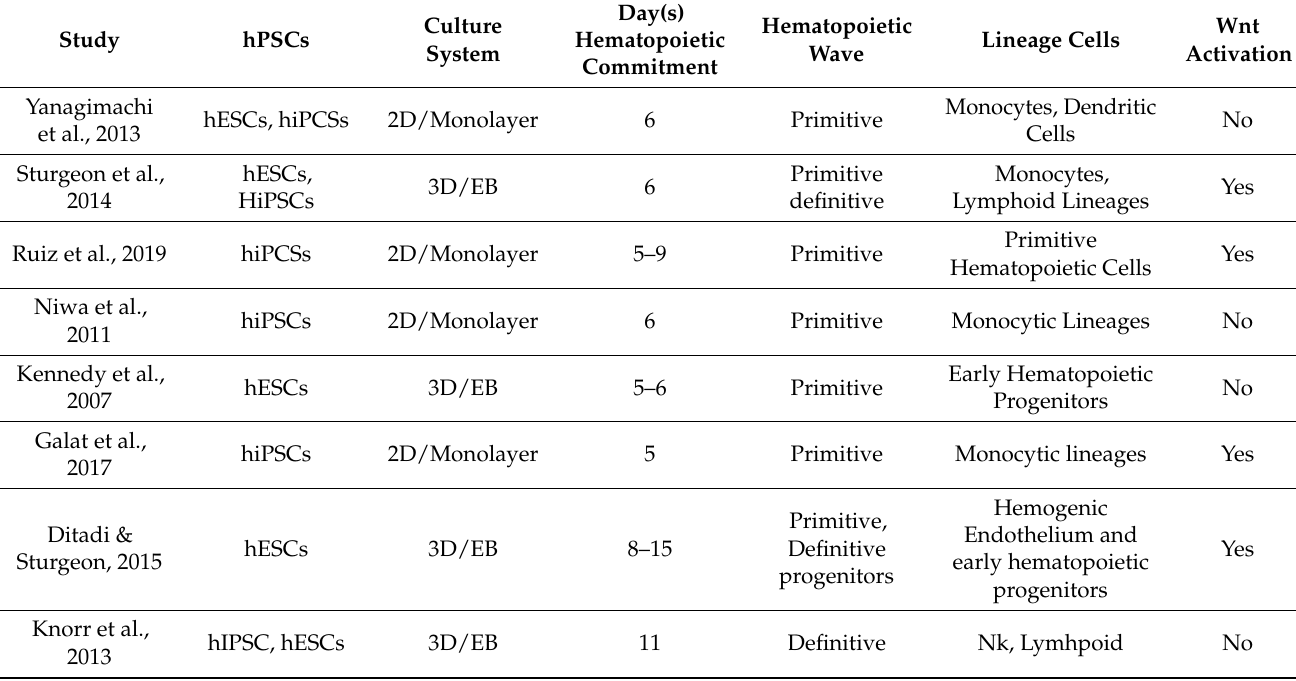
Table 1. Selected publications on the independent use of 3D/Embryoid Body and 2D/monolayer systems in hematopoietic differentiation from hPSCs. The table displays the differences in the generation of hematopoietic lineages under these two conditions. Additionally, results show the importance of Wnt/ β -catenin signaling activation during in vitro differentiation of hPSCs of the definitive hematopoietic